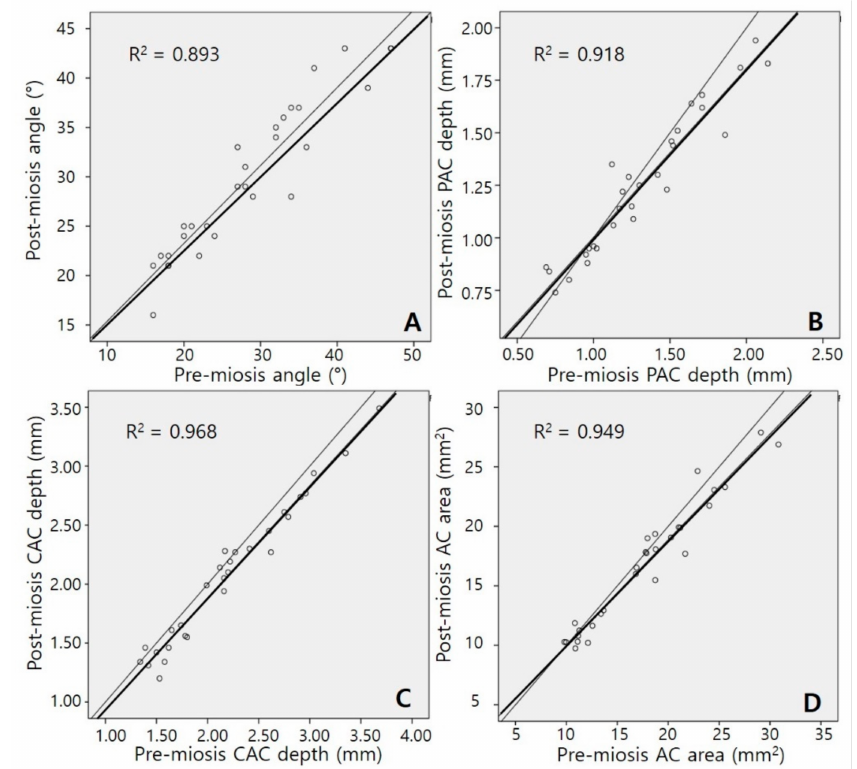
Figure 2. Scatter plots of anterior chamber (AC) parameters in the phakia group. ( A ) AC angle, ( B ) peripheral anterior chamber (PAC) depth, ( C ) central anterior chamber (CAC) depth, and ( D ) AC area. Correlations between pre-miosis and post-miosis values in all parameters were strongly positive and statistically significant (all p < 0.001). The thin line represents Y =